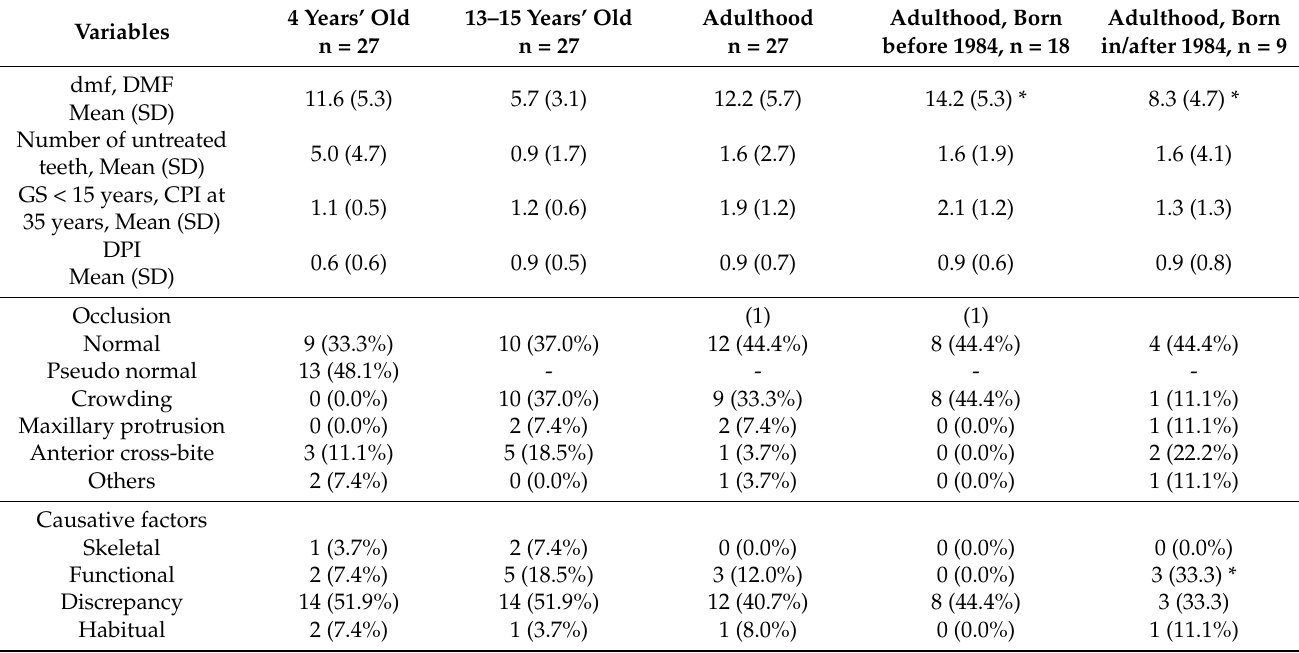
Table 3. Longitudinal change in oral conditions.